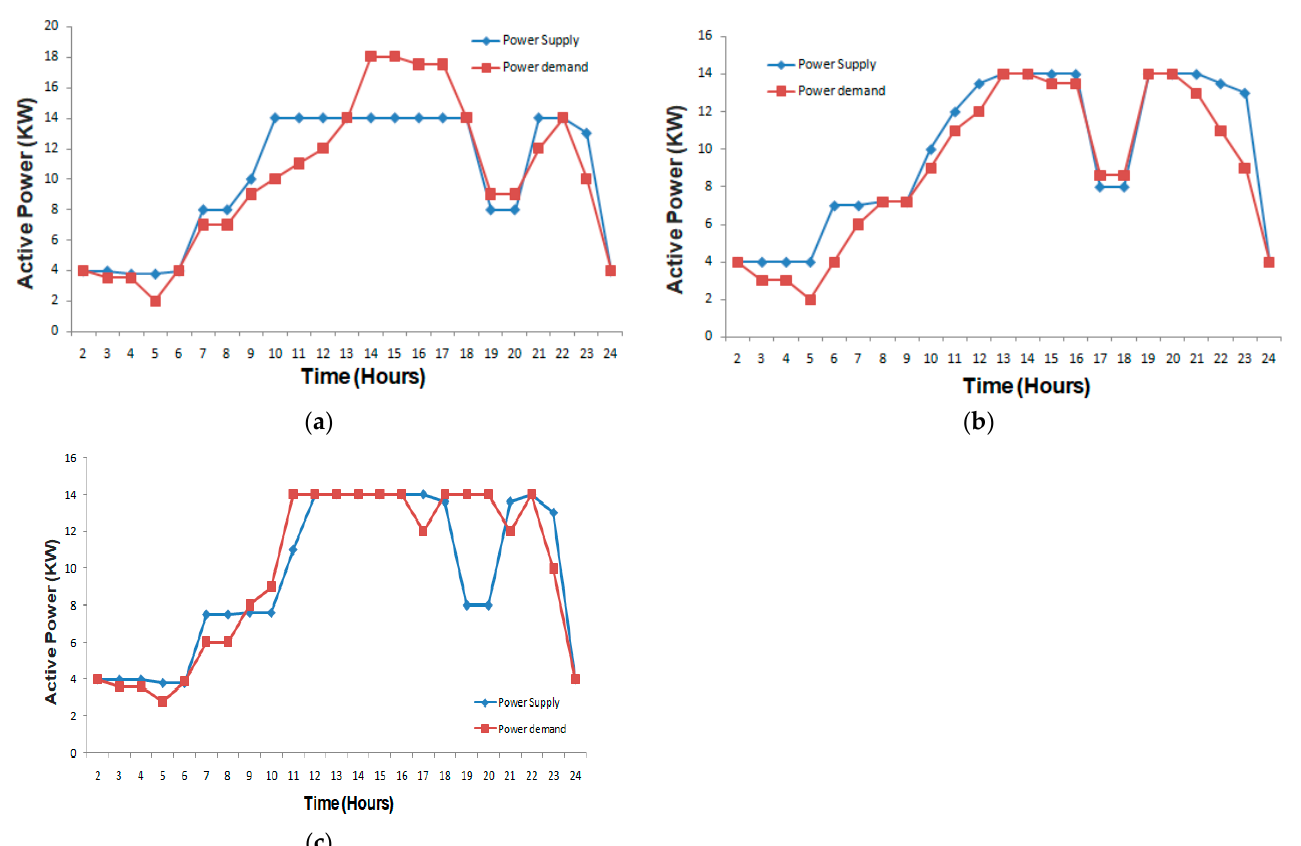
Figure 20. ( a ) Demand response analysis during islanded mode without load curtailment. ( b ) De- mand response analysis during islanded mode with load curtailment. ( c ) Demand response analy- sis during islanded mode showing load shifting/adjustment using